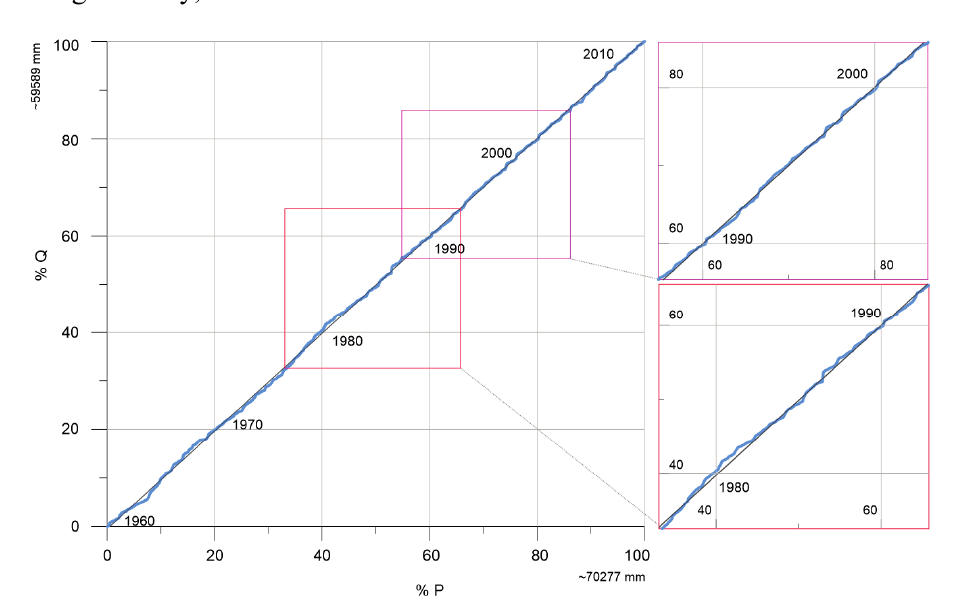
Figure 5. Double-mass curve of accumulated monthly values of discharge (Q) at Vydra-Modrava and precipitation (P) at Filipova Hut stations during 1961–2010 and two magnified periods of the 1980s and the